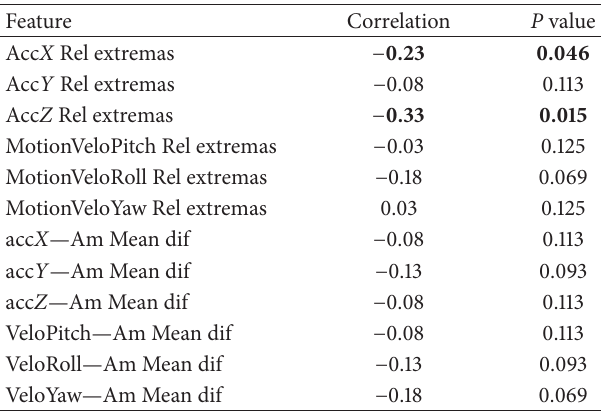
Table 2: The postexperiment analysis results of the preceding experiment described in [11]. Here the P values are also obtained from a binomial distribution with expected probability of 0.5.